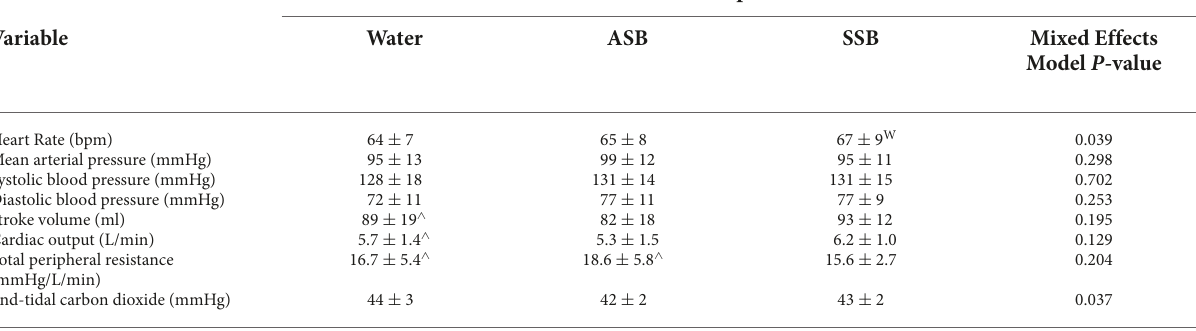
TABLE 1 Seated baseline cardiovascular and end-tidal carbon dioxide values 20 min after consuming each experimental beverage.